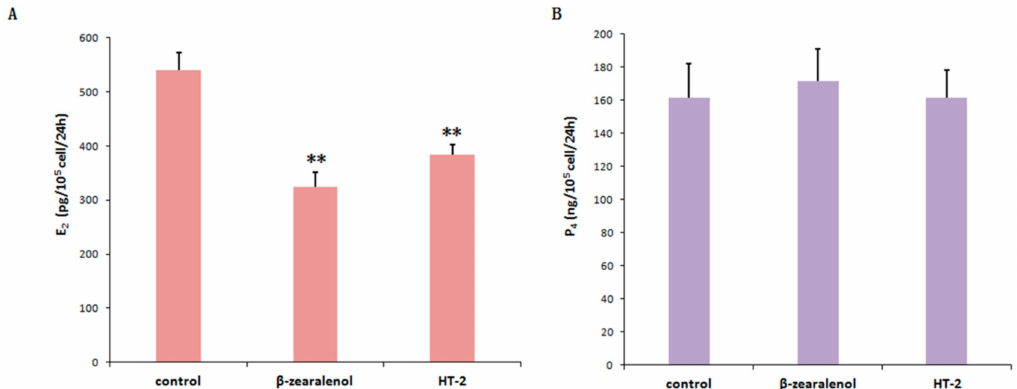
Figure 6. The release of E 2 and P 4 in bovine granulosa cells cultured under mycotoxins and a corresponding control over 24 h. ( A ) E 2 levels in bovine granulosa cell culture medium; ( B ) P 4 levels in bovine granulosa cell culture medium). Values are expressed the mean ± S.D. of n = 3. ** p < 0.01 versus that of the control group; CON, control group; β -zol, β -zearalenol treatment; HT-2, HT-2 treatment.